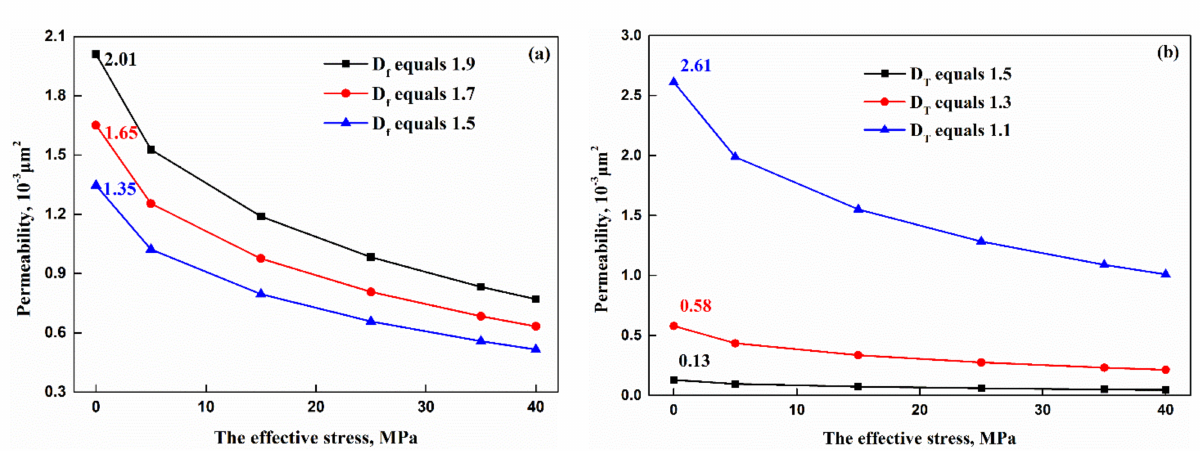
Figure 5. The effect of PSD on permeability under various effective stresses. (( a ) Pore fractal dimensions; ( b ) tortuosity fractal dimensions).